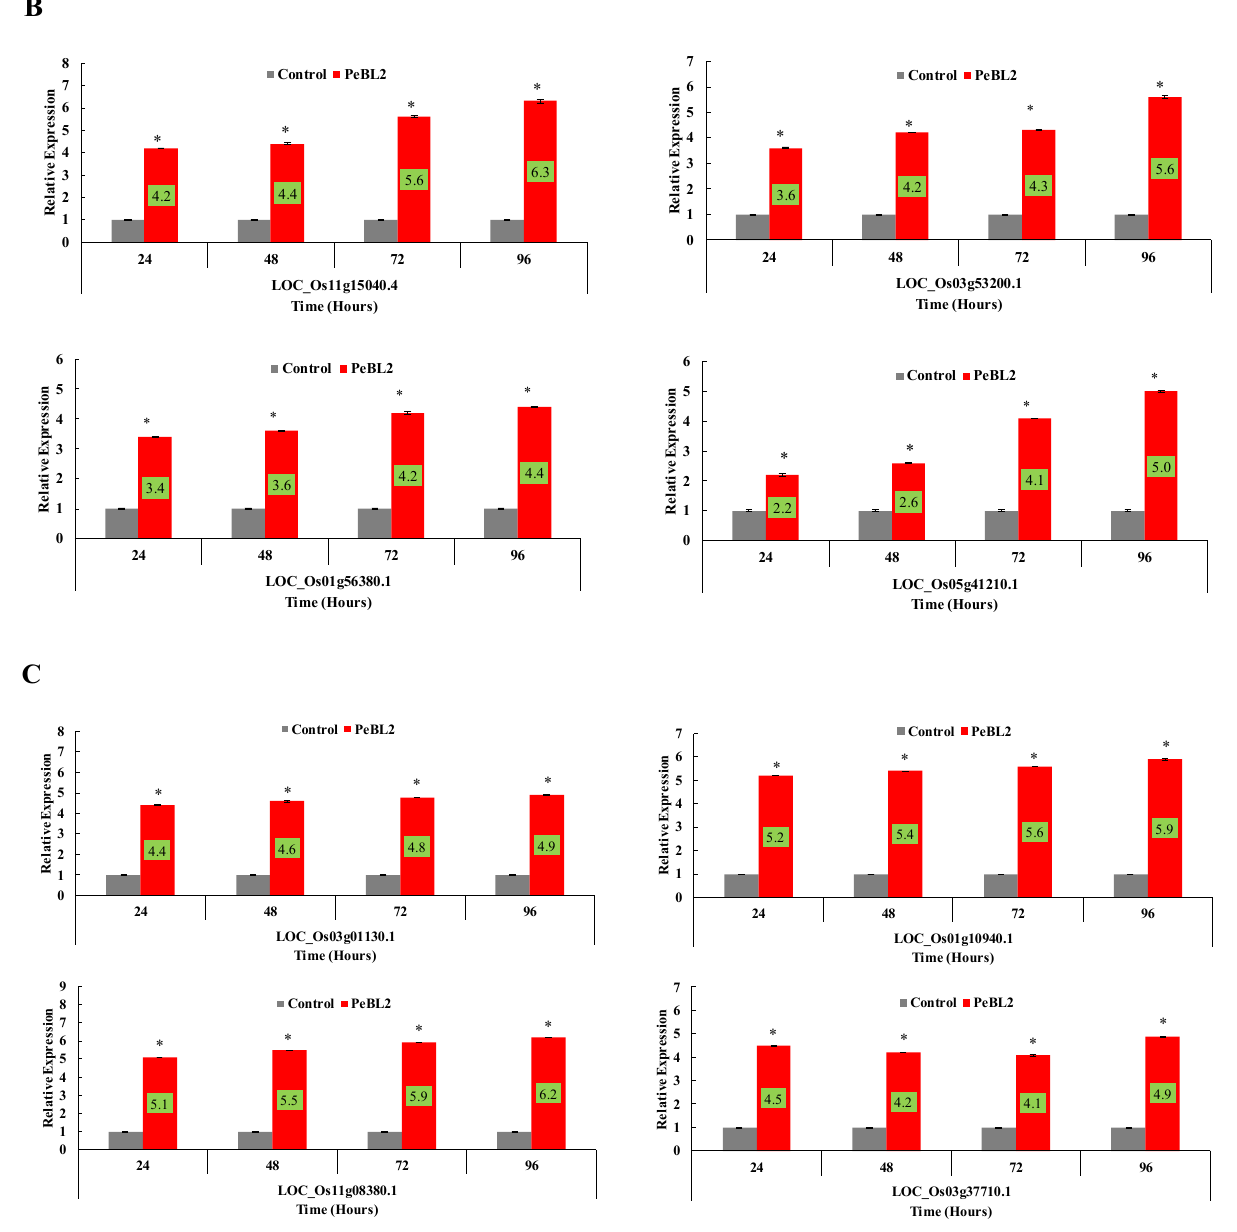
Figure 8. Relative expression of plant defense from JA ( A ), SA ( B ), and ET ( C ) pathways found at various time intervals after treatment with PeBL2 elicitor and aphid infestation. For each gene, an asterisk on bar shows a significant difference from control by Student’s t-test ( p < 0.05).